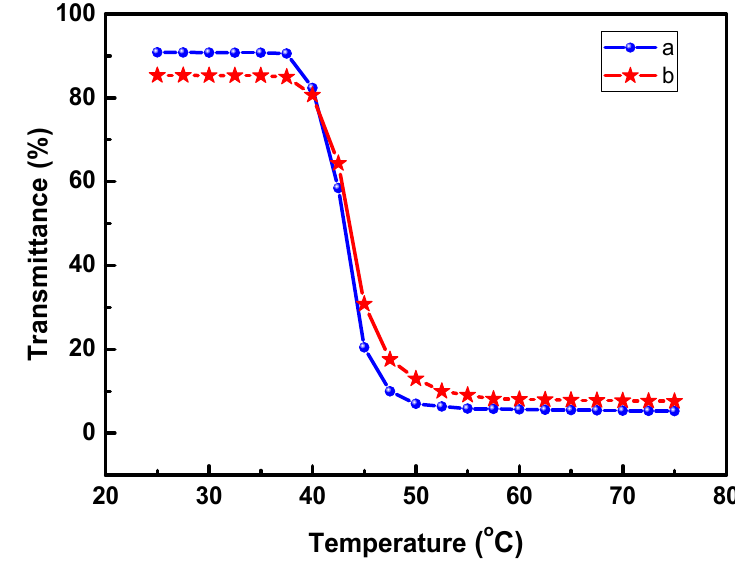
Figure 1. Variation of optical transmittance with temperature (30–80 °C): ( a ) POF 10 – b– PDPAEMA 197 and ( b ) POF 10 – b– PDPAEMA 90 .